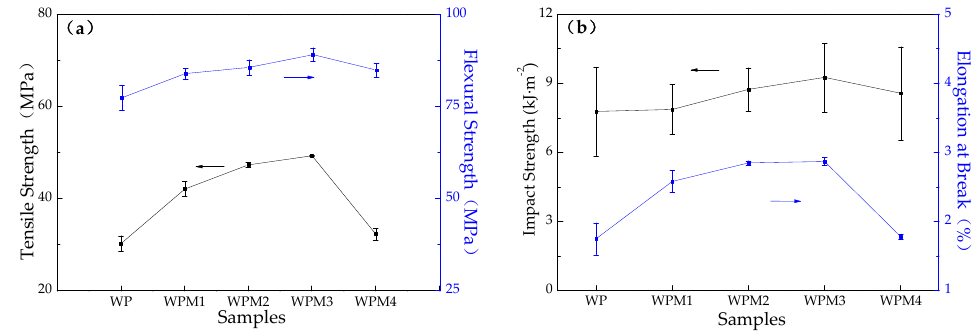
Figure 5. Mechanical properties of wood flour/PLA composites with different PLA- g -St/MAH loading rates: ( a ) tensile strength and flexural strength; ( b ) impact strength and elongation at break.